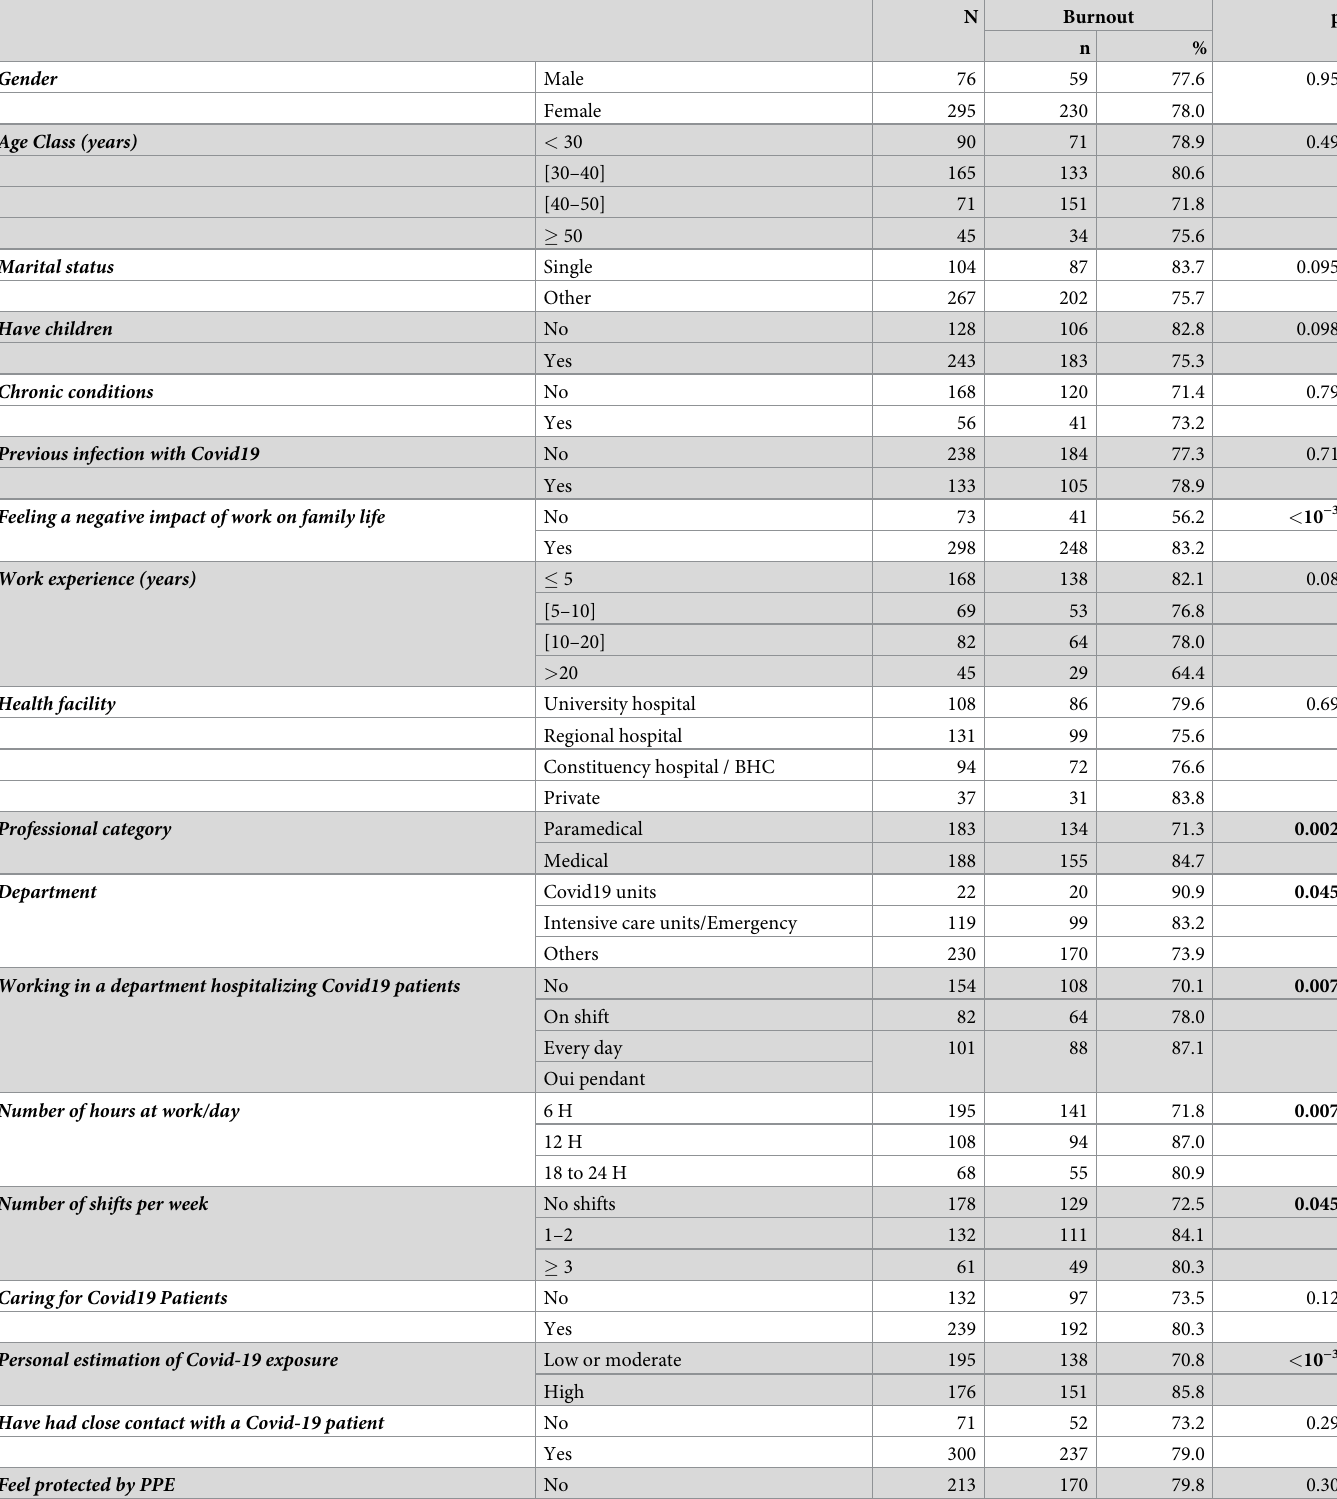
Table 3. Associated factors with burnout among health professionals during the Covid19 pandemic in Monastir (Univariate